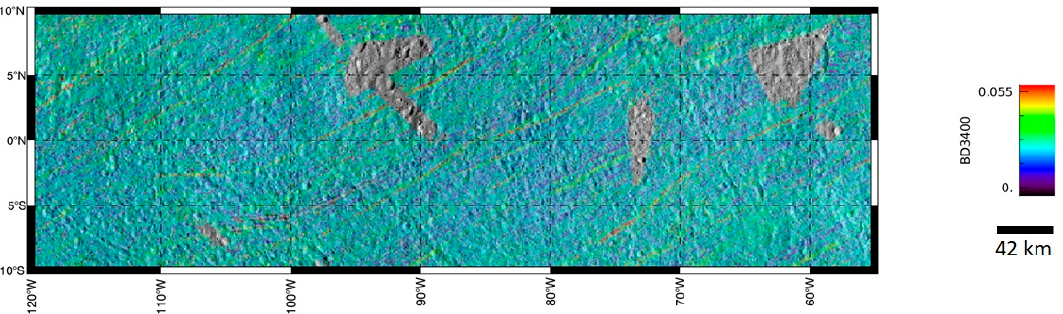
Figure 9. The 3.4 μ m band depth distribution of the Samhain Catenae region (cylindrical projection). No observable variations arise.